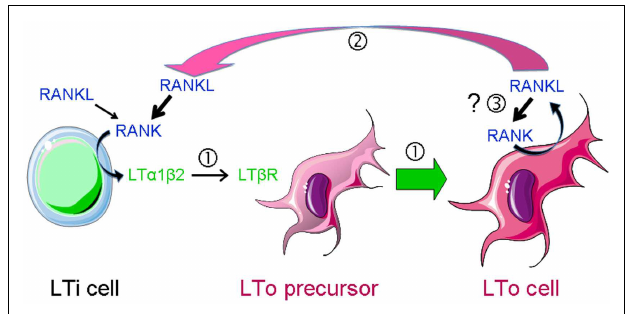
FIGURE 2 | RANKL-dependent amplification loops in SLO development. SLO development during embryogenesis is initiated by the recruitment of lymphoid tissue inducer (LTi) cells to a rudimentary organ anlage composed of mesenchymal lymphoid tissue organizer (LTo) cell progenitors.This step is followed by a cross-talk between LTi cells that express RANKL, RANK, and LT αβ and LTo cells that carry LT β R . Engagement of the latter induces the maturation of LTo cells to express RANKL and chemokines that attract larger numbers of LTi cells that upon clustering with LTo cells initiate LN organization. LTo cells also express RANKL.The current model of LN development indicates that a positive feedback loop takes place between LTo and LTi cells via RANKL-RANK and LT αβ -LT β R amplifying the early stages of LN development . If LTo cells expressed also RANK, a second (autocrine) loop may occur, leading to a direct activation of LTo cells